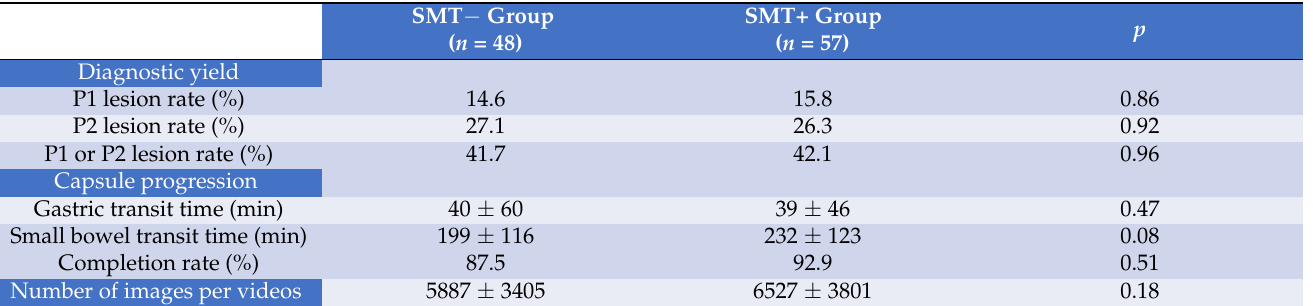
Table 3. Number of images per video (mean and SD), mean transit times per segment, diagnosis yield (%) and completion rate (%) in each group. SMT − stands for “without simethicone” whereas SMT+ means “with